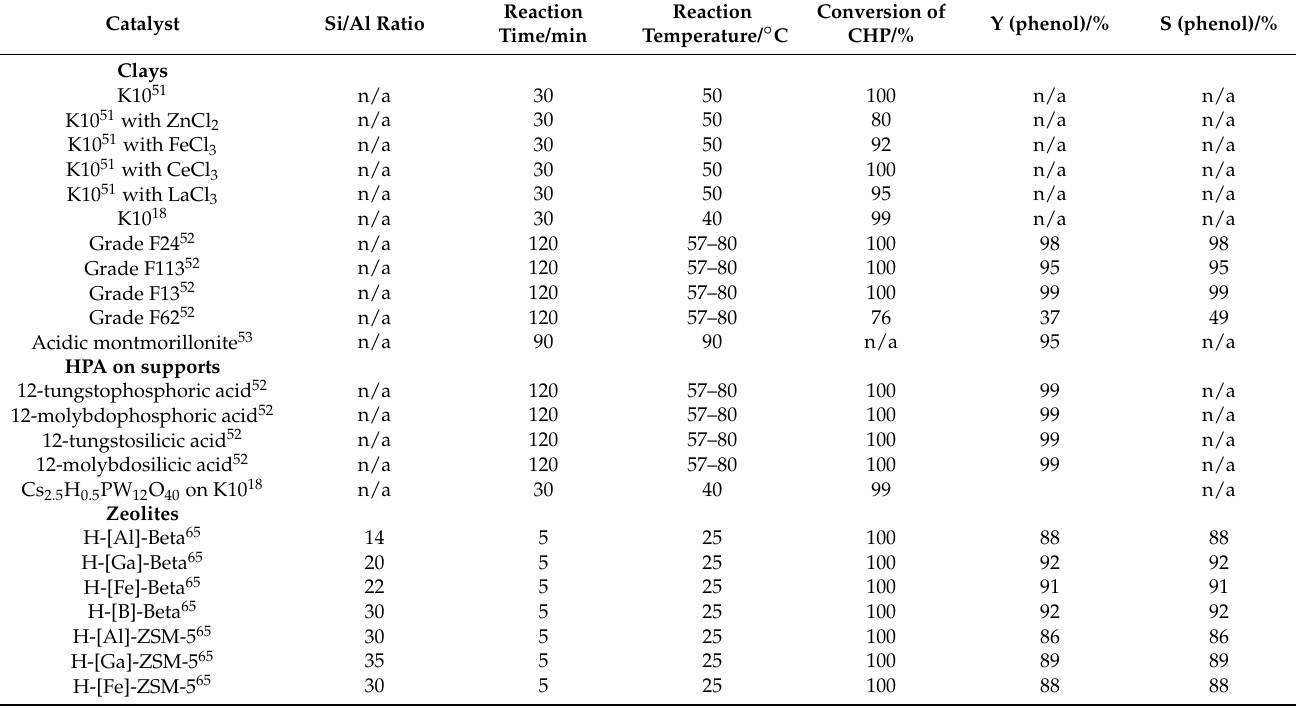
Table 1. Catalytic decomposition of cumene hydroperoxide over various